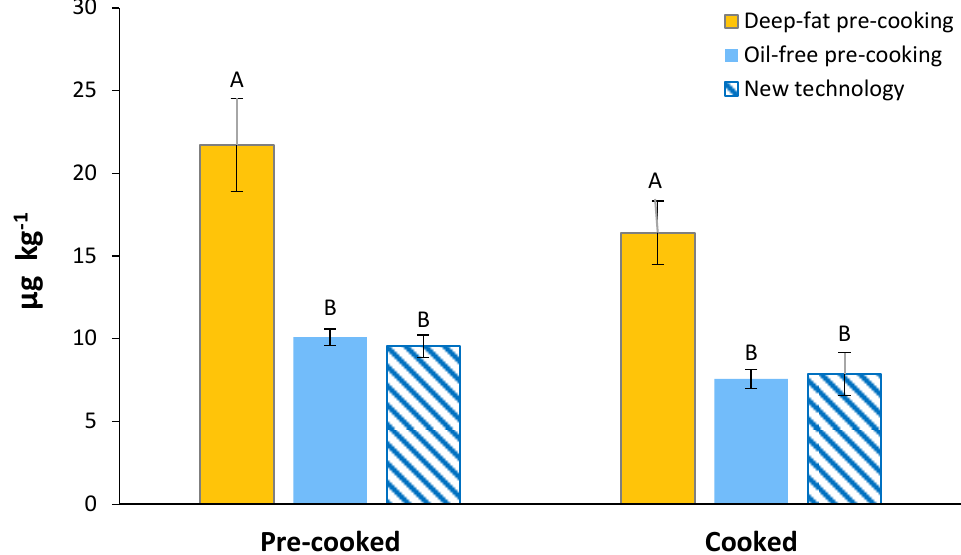
Figure 7. Acrylamide contents (ug kg − 1 ) of pre-cooked (different methods) chicken nuggets stored up to 11 days at 4 °C (n = 3 ± SD). Different letters denote significant differences ( p < 0.05) among pre-cooked or cooked.